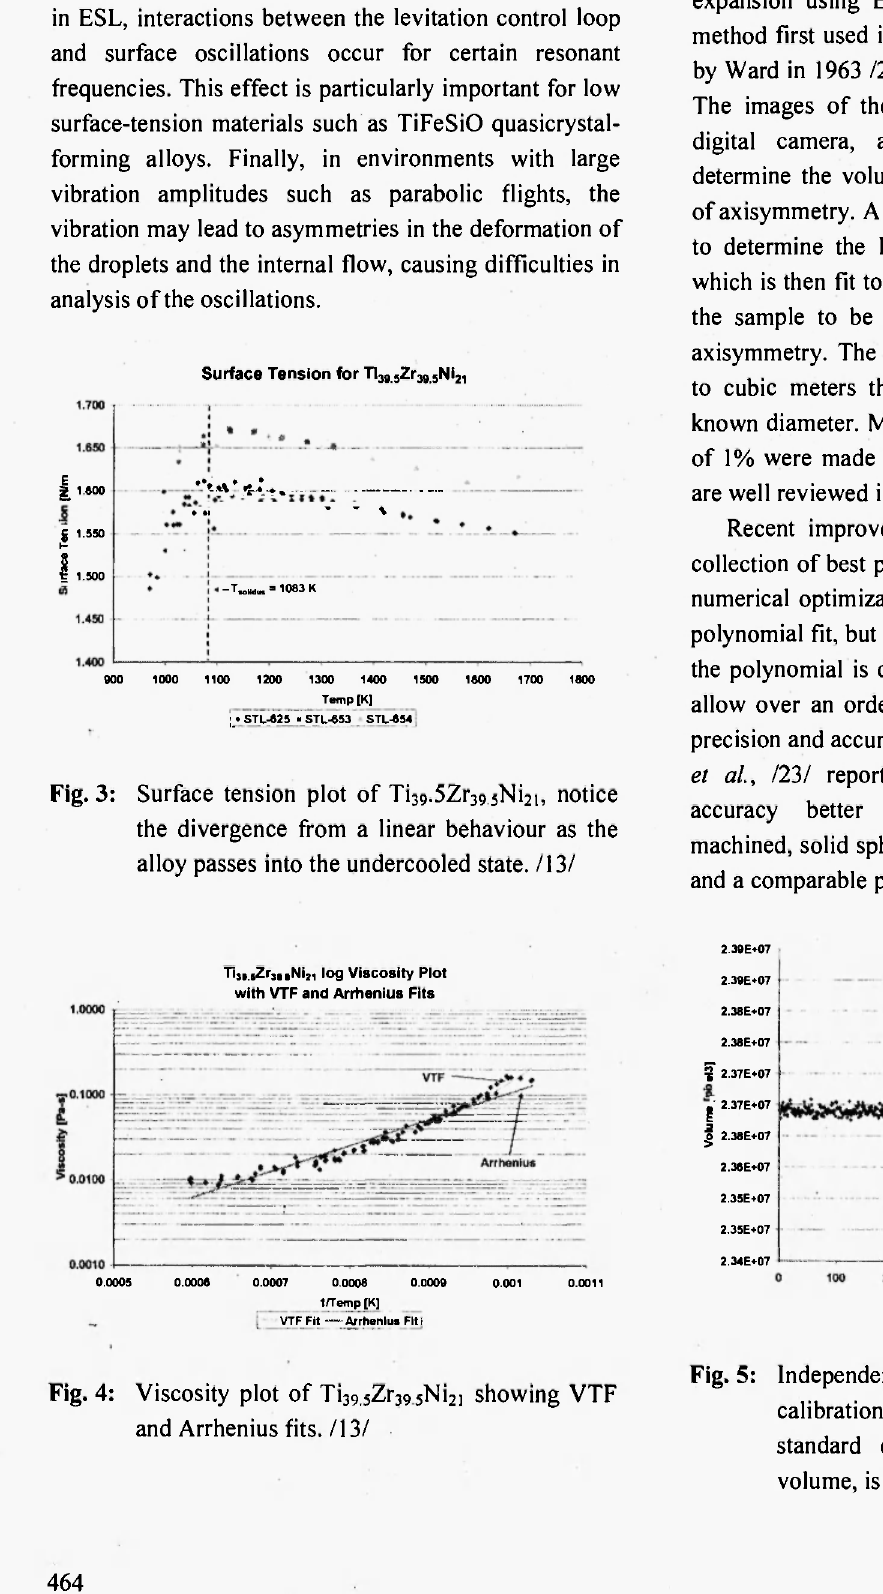
Fig. 5: Independent measurements of a Grade 3 sphere (75 nm sphericity). The standard error, normalized by the average volume, is 0.0265 %.